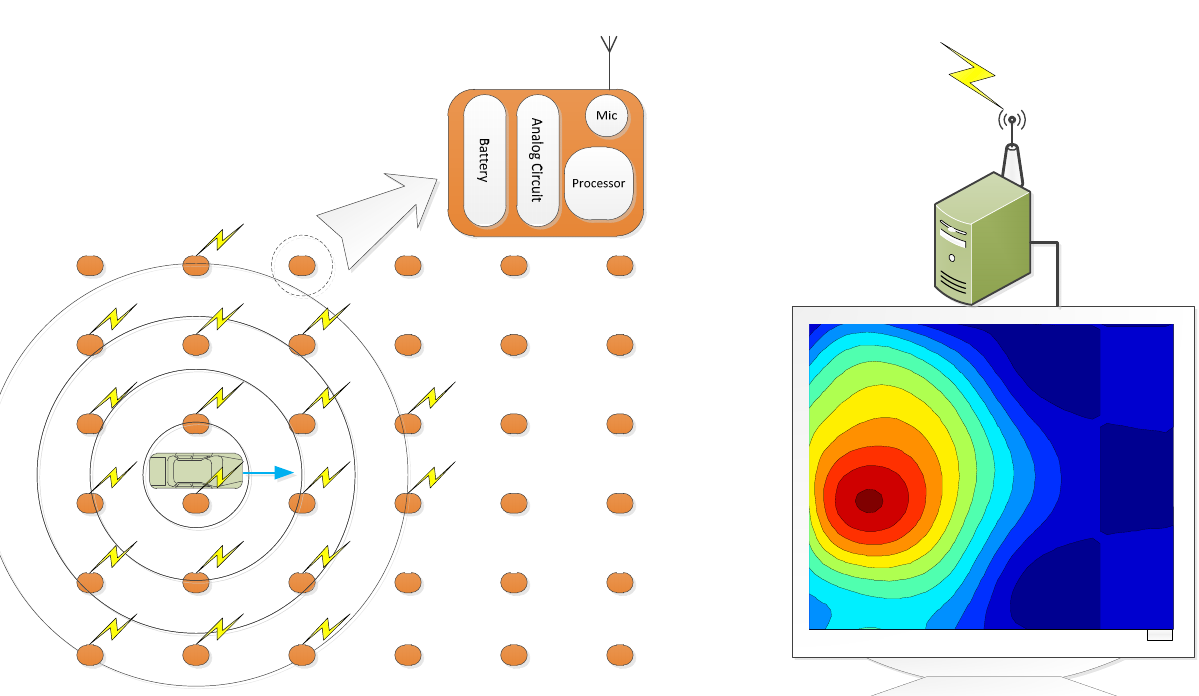
Figure 1. The functional diagram of the PVVE